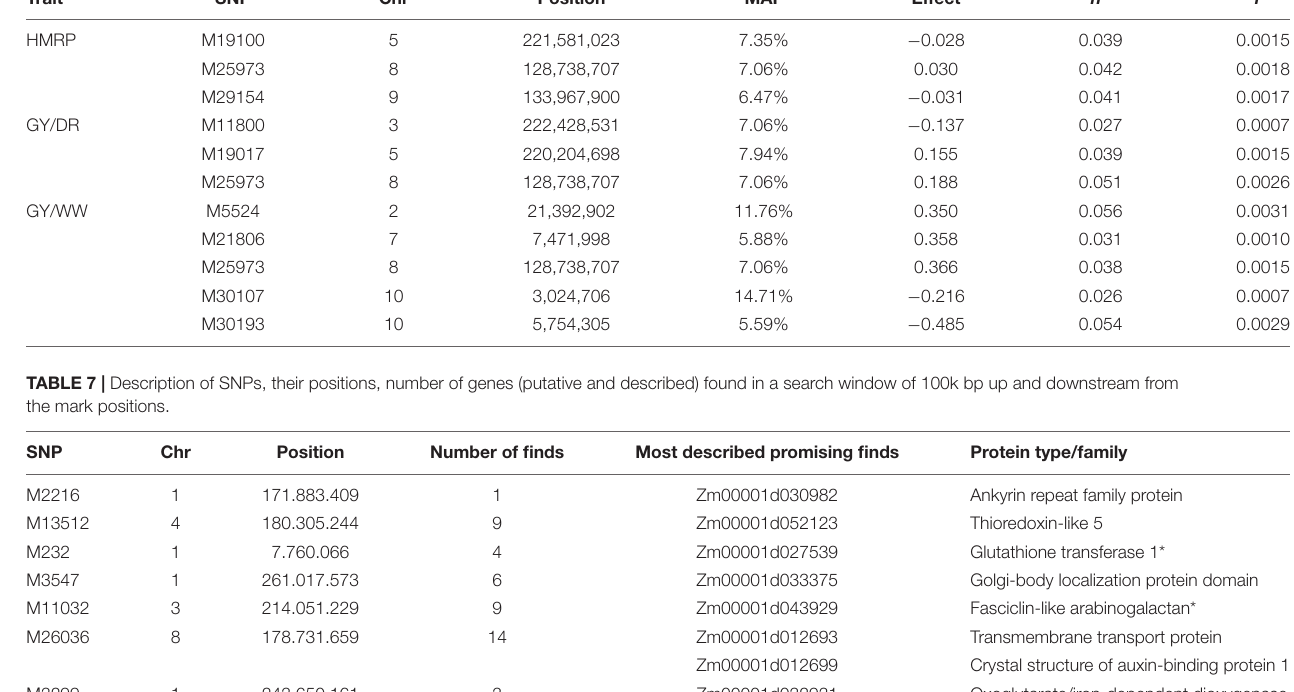
TABLE 6 | Significant SNPs for drought-tolerance index and grain yield in drought and well-watered conditions, with the SNP position (chromosome and position), minor frequency allele, effect, heritability, and r 2 for the GWAS of BC1S2 generation. Trait SNP Chr